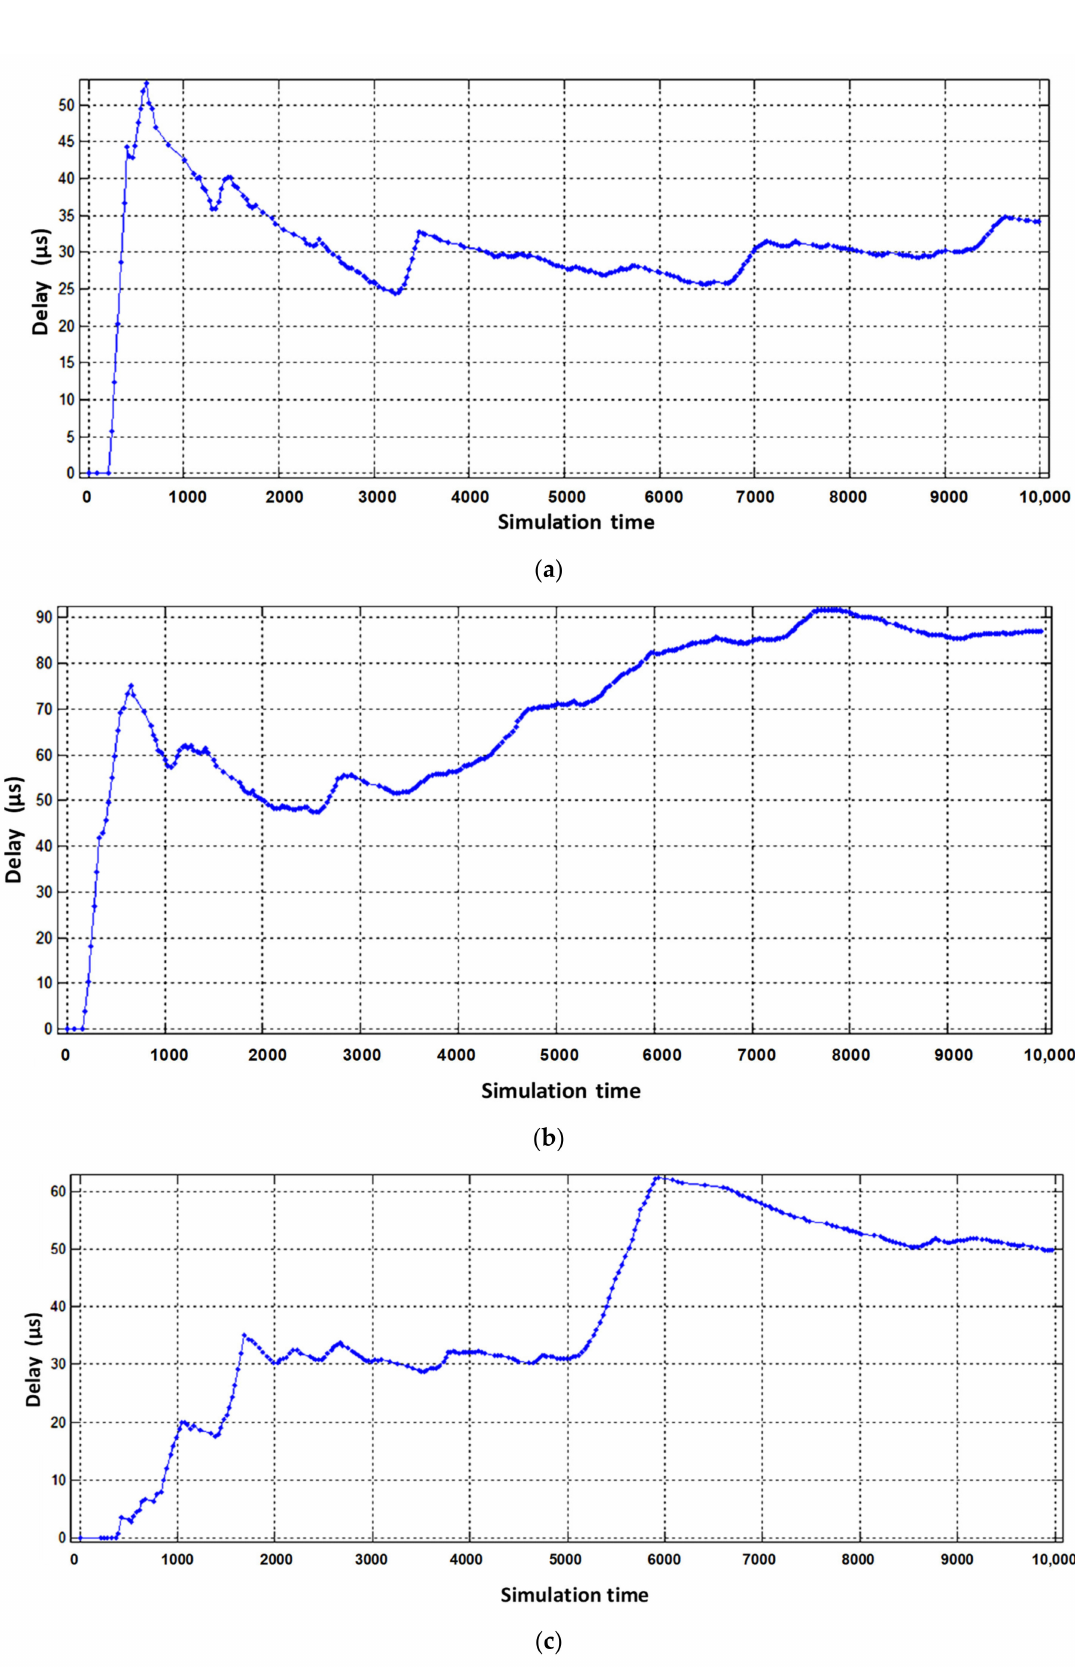
Figure 11. Delay of virtual router buffering when serving ( a ) video, ( b ) voice, ( c )